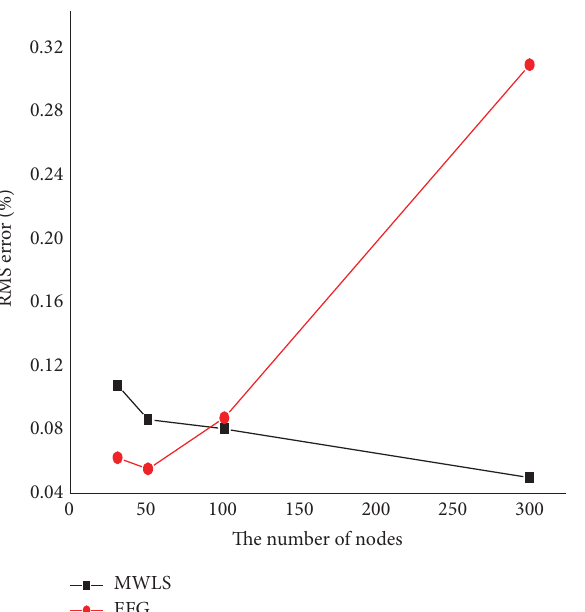
Figure 1: Variation of RMS error at different nodes.